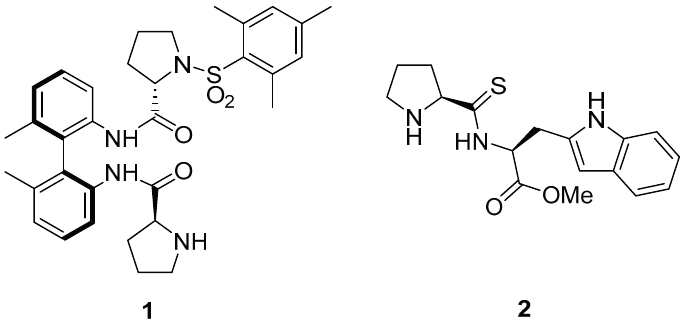
Figure 1. Prolinamides used in the solvent-free conditions aldol reaction of isatins.